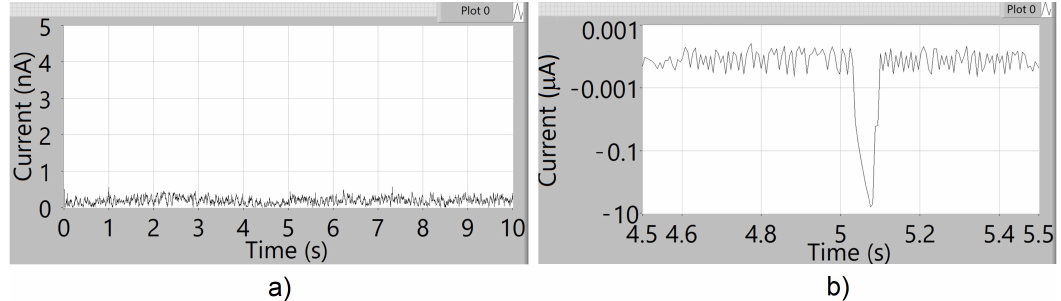
Figure 10. Current in GEM TOP 1. ( a ) Current in the stable state. ( b ) Current with a discharge, the plot shows the current in logarithmic scale.